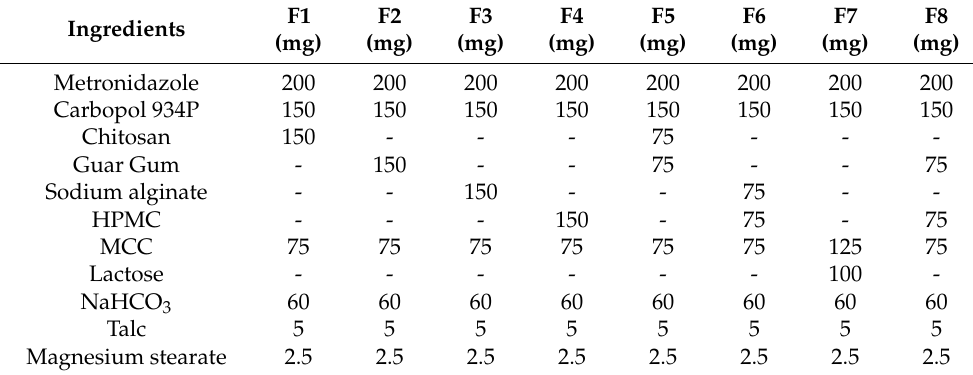
Table 4. Composition of floating tablets of metronidazole.